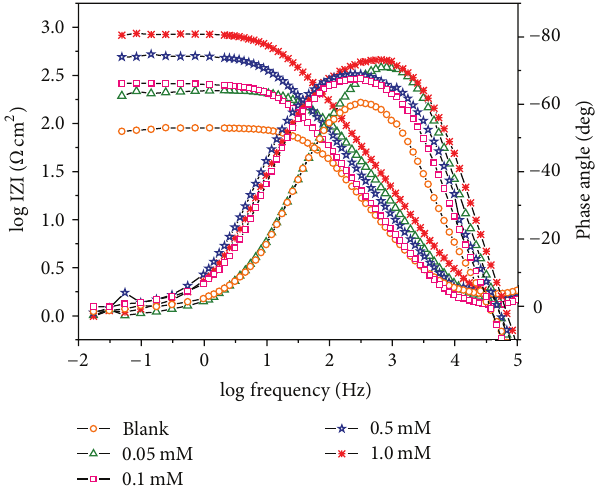
Figure 9: Bode plots of mild steel in 1M HCl solution without and with different concentrations of